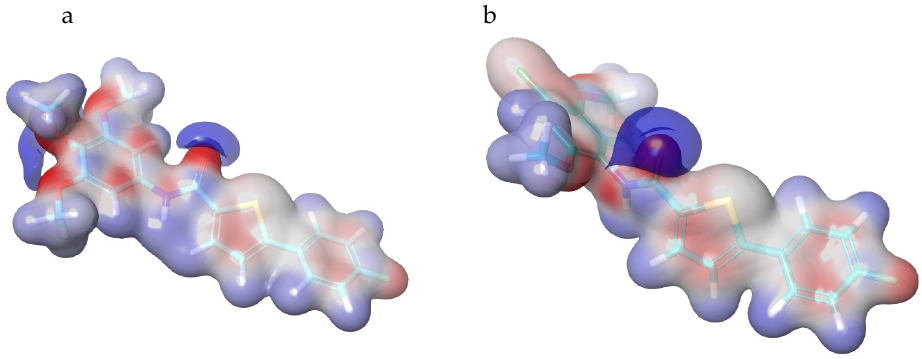
Figure 6. Electrostatic potential profiles of 2b ( a ) and 2e ( b ) compounds. The red color indicates high electro-negativity.